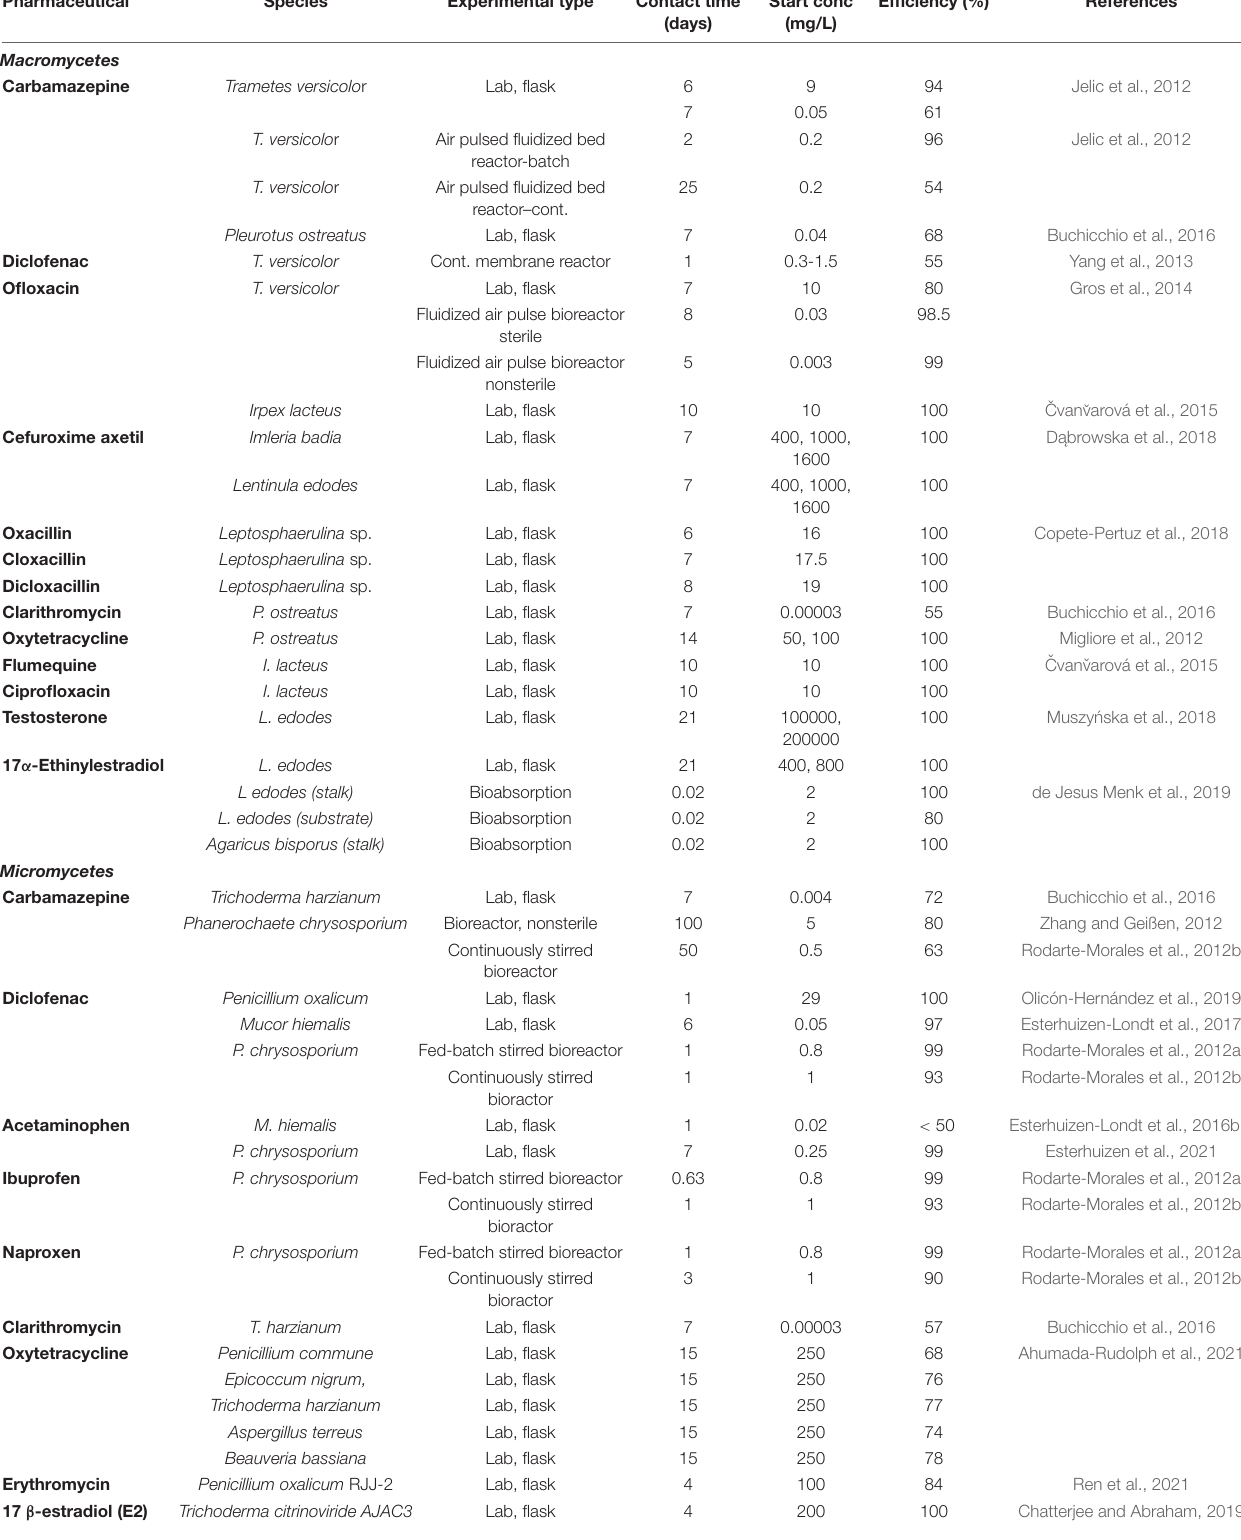
TABLE 3 | Summary of fungal remediation studies on the removal efficiency of single PhAC. Pharmaceutical Species Experimental